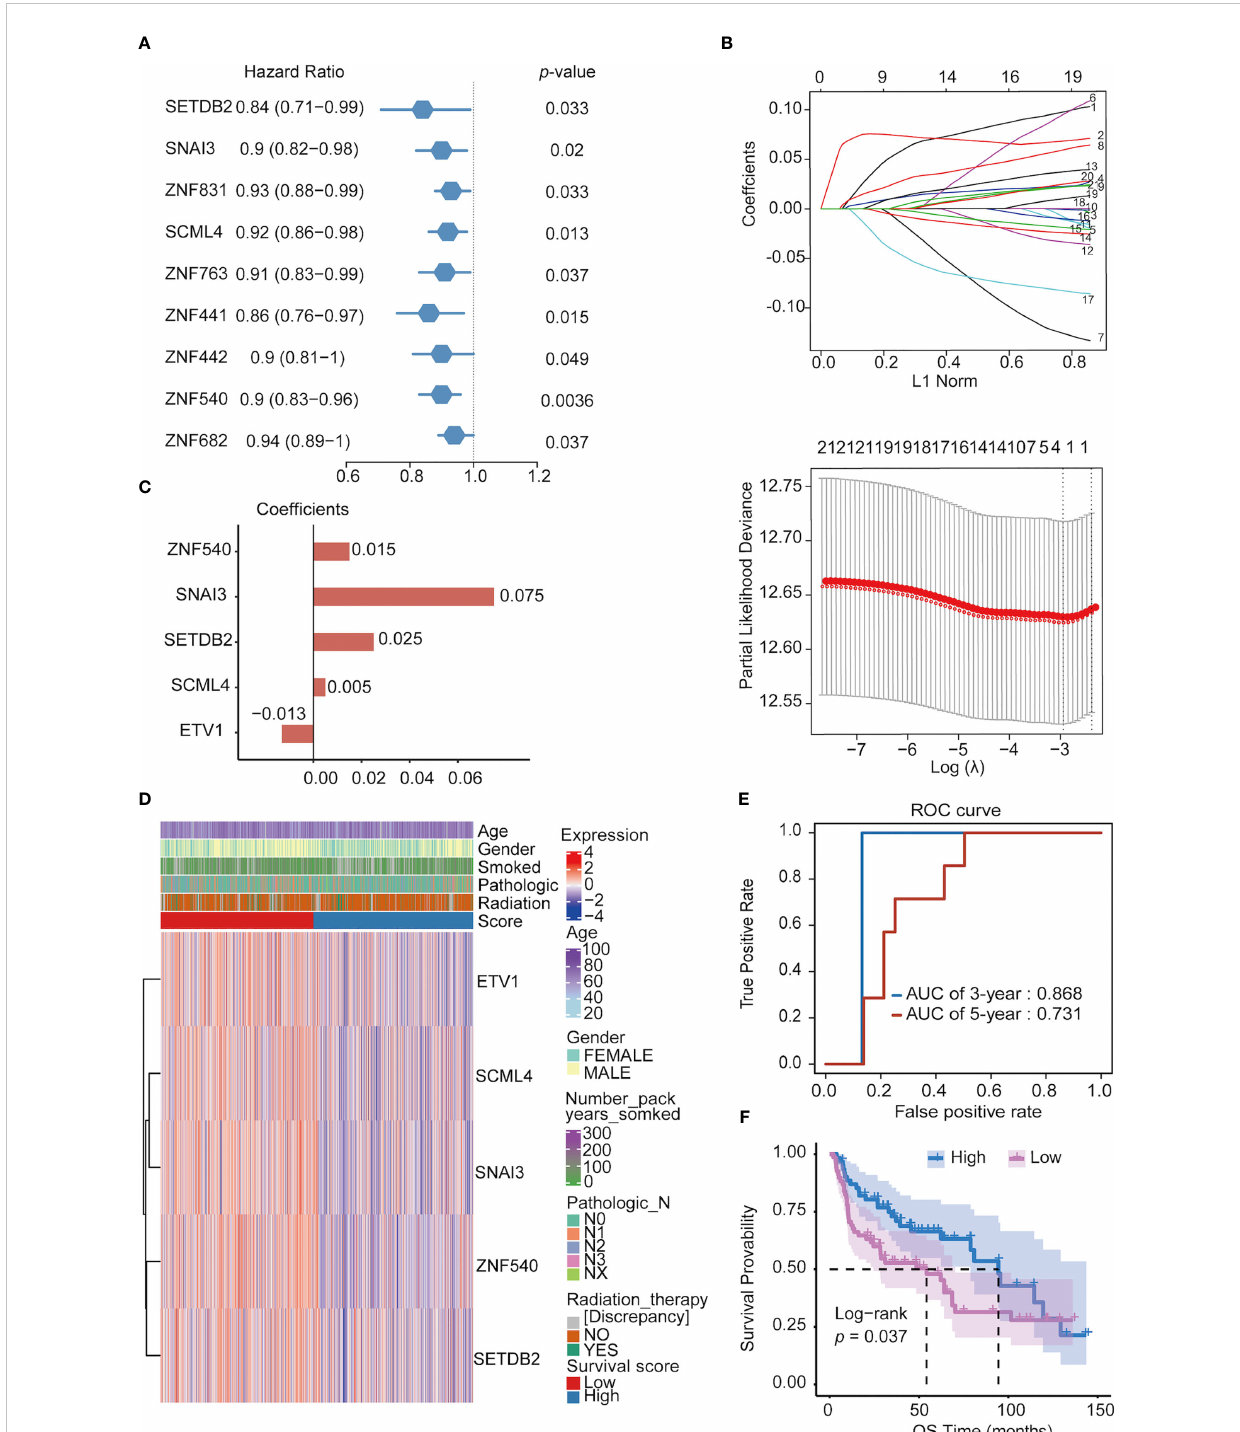
FIGURE 4 Constructing prognostic TFs in NSCLC. (A) Univariate Cox regression analysis of TFs. (B) Line plot of least absolute shrinkage and selection operator (LASSO) regression analysis of 30 TFs in NSCLC. (C) Coef fi cients of relevant 5 TFs in LASSO regression result. (D) Heatmap of the fi ve prognosis- related TFs expression pro fi les combined with clinical traits in the high- and low-score groups. (E) ROC curve of 3- and 5- year survival probability in NSCLC cancer from the UCSC dataset. (F) Kaplan – Meier analysis of high- and low-score groups for NSCLC from the UCSC